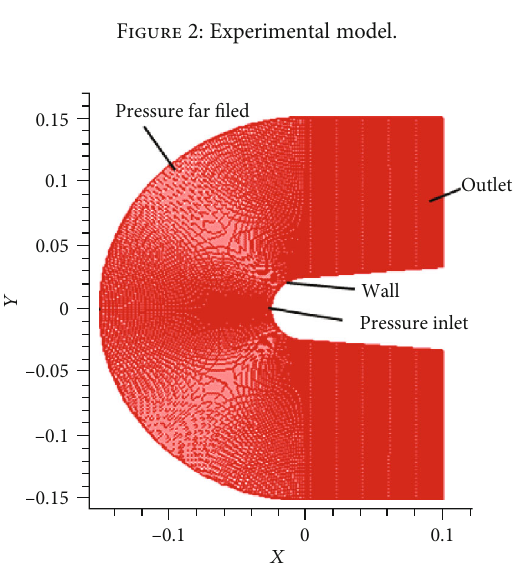
Figure 3: Numerical simulation